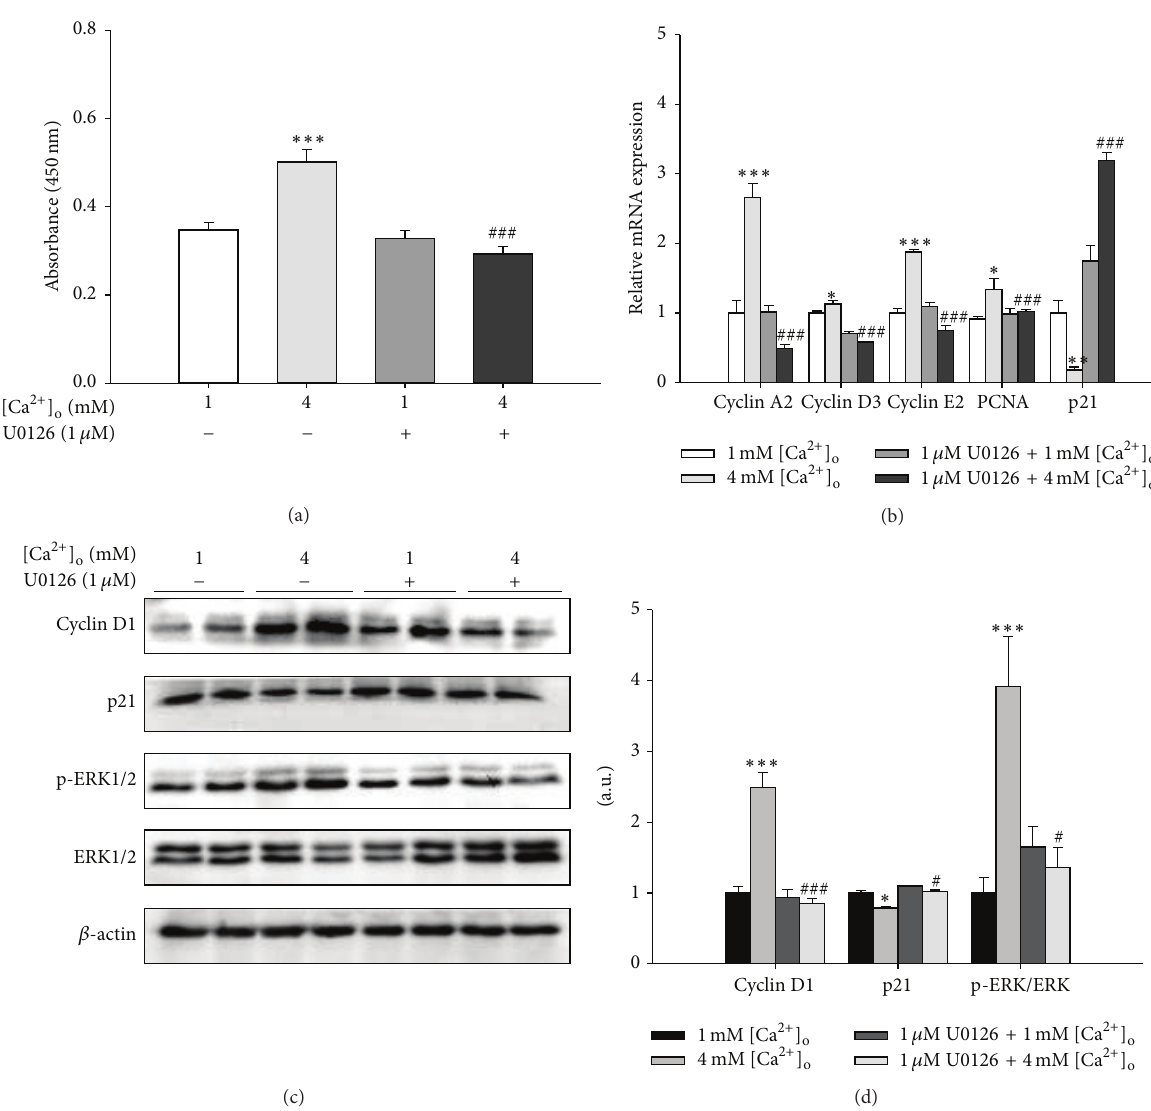
Figure 5: Inhibition of ERK pathway abolished [ Ca 2+ ] o -induced proliferation of pBMSCs. (a) Effects of U0126 (1 𝜇 M), an inhibitor of MEK, on the proliferation of pBMSCs after 5-day incubation ( 𝑛 = 8 ). (b) The mRNA expression levels of cyclins (cyclin A2, cyclin D3, and cyclin E2), PCNA, and p21 in response to 4mM [ Ca 2+ ] o and/or 1 𝜇 M U0126. (c) Western blot analysis of cyclin D1, p21, phosphor-ERK (p-ERK), and ERK in pBMSCs after 5-day culture. 𝛽 -actin was used as loading control. (d) Mean ± SEM of immunoblotting bands of cyclin D1, p21, and p-ERK/ERK. The intensities of the bands were expressed as the arbitrary units ( 𝑛 = 4 ). ∗ 𝑃 < 0.05 and ∗∗∗ 𝑃 < 0.001 versus 1mM [ Ca 2+ ] o group (control); # 𝑃 < 0.05 and ### 𝑃 < 0.001 versus 4 mM [ Ca 2+ ] o